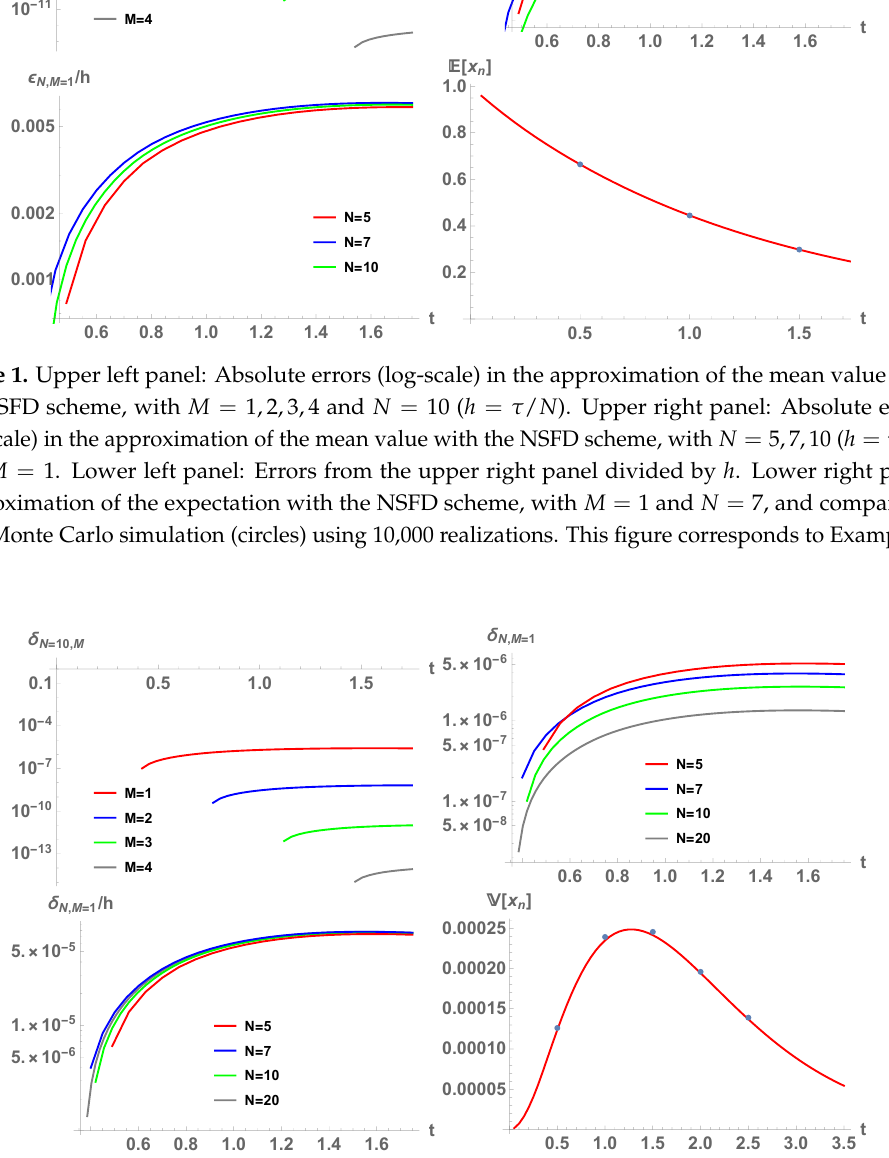
Figure 2. Upper left panel: Absolute errors (log-scale) in the approximation of the variance with the NSFD scheme, with M = 1,2,3,4 and N = 10 ( h = τ / N ). Upper right panel: Absolute errors (log-scale) in the approximation of the variance with the NSFD scheme, with N = 5,7,10,20 ( h = τ / N ) and M = 1. Lower left panel: Errors from the upper right panel divided by h . Lower right panel: Approximation of the variance with the NSFD scheme, with M = 1 and N = 7, and comparison with Monte Carlo simulation (circles) using 10,000 realizations. This figure corresponds to Example